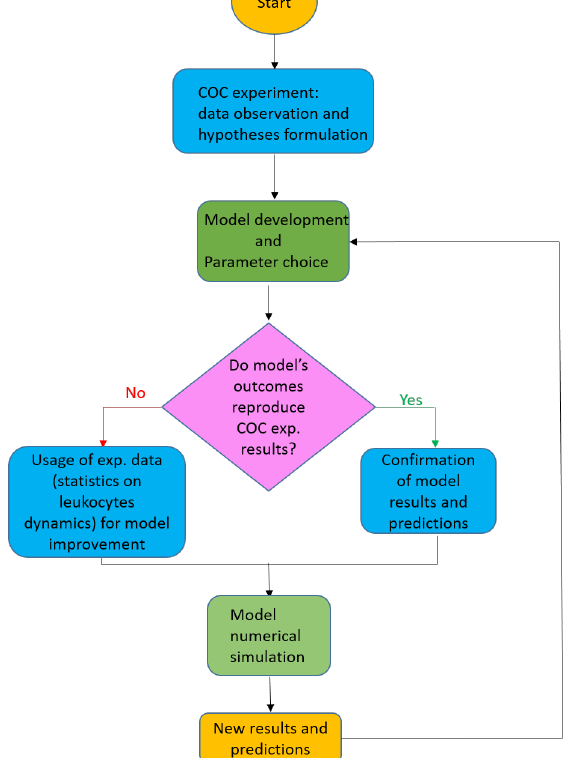
Figure 1. Flowchart schematizing the procedure applied in the present